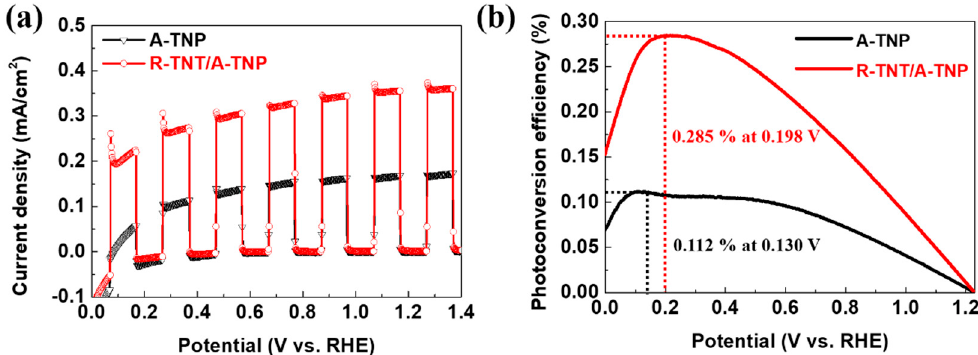
Figure 5. PEC performance of R-TNT/A-TNP and A-TNP: ( a ) J-V curves under chopped light illumination; ( b ) photoconversion efficiency as a function of applied potential.